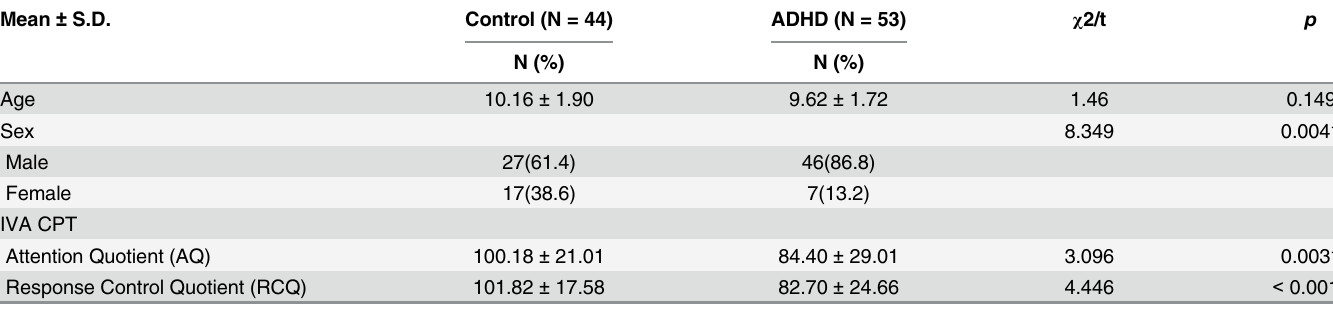
Table 1. Demographic characteristics and IVA CPT